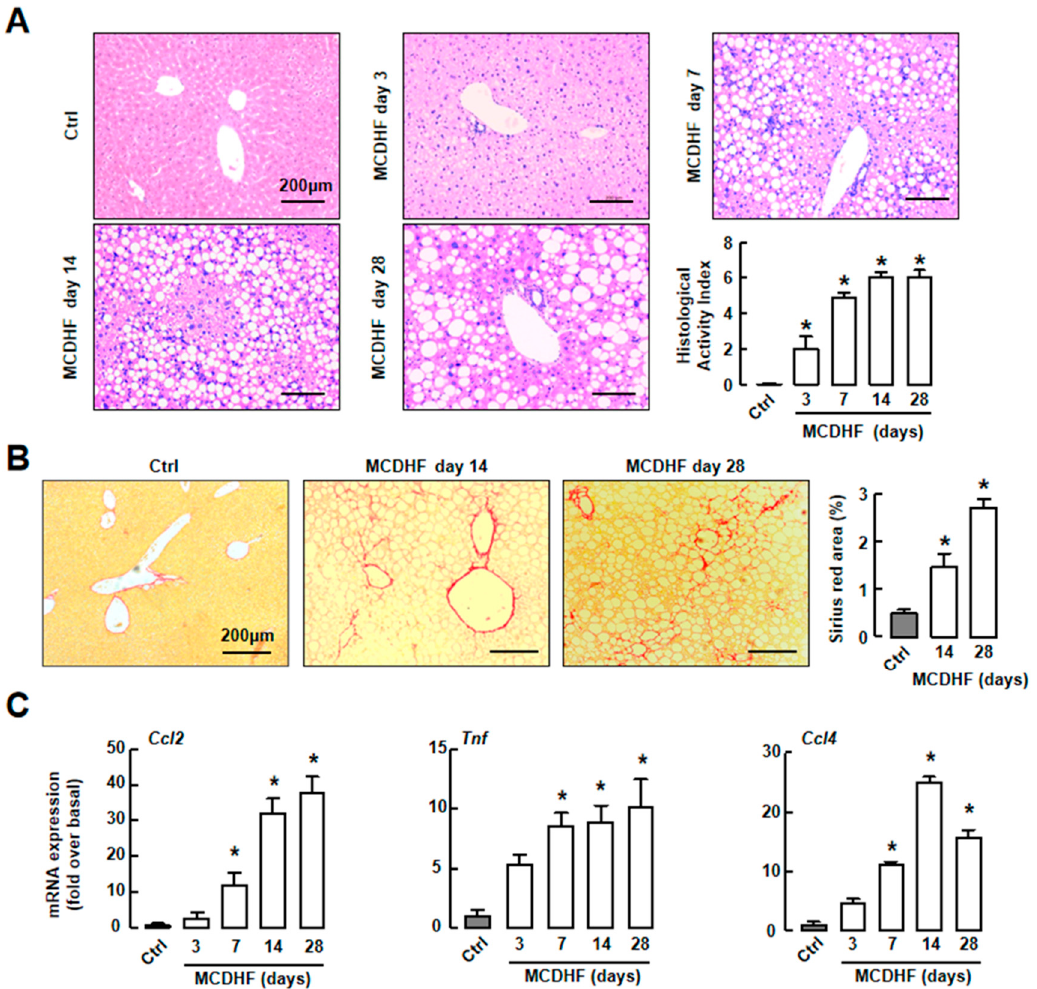
Figure 1. Characterization of hepatic steatosis, inflammation, and fibrosis during methionine-choline- deficient and high-fat diet (MCDHF) diet-induced mouse fatty liver damage. ( A ) The extent of inflammation and steatosis in the livers of MCDHF diet-fed mice were detected by H&E staining from day 3 to day 28. Scale bars = 200 µ m. ( B ) The extent of hepatic fibrosis in the livers of MCDHF diet-treated mice was detected by Sirius Red staining. Scale bars = 200 µ m. ( C ) Hepatic mRNA expressions of MCP-1 ( Ccl2 ), TNF- α ( Tnf ), and MIP-1 β ( Ccl4 ) were determined by RT-qPCR. Data are presented as the means ± SEM. * p < 0.05 versus the control group ( n = 6 for each group in each experiment).